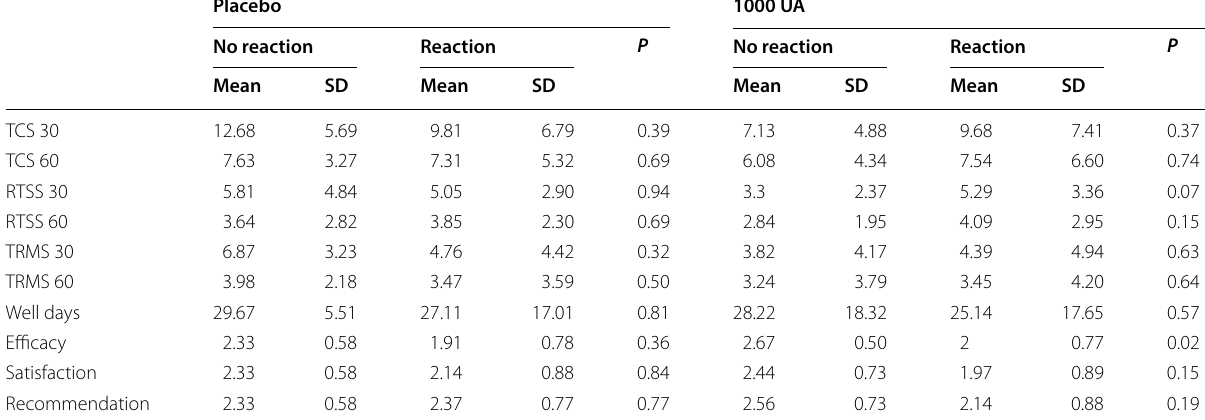
Table 6 Results of the grass pollen